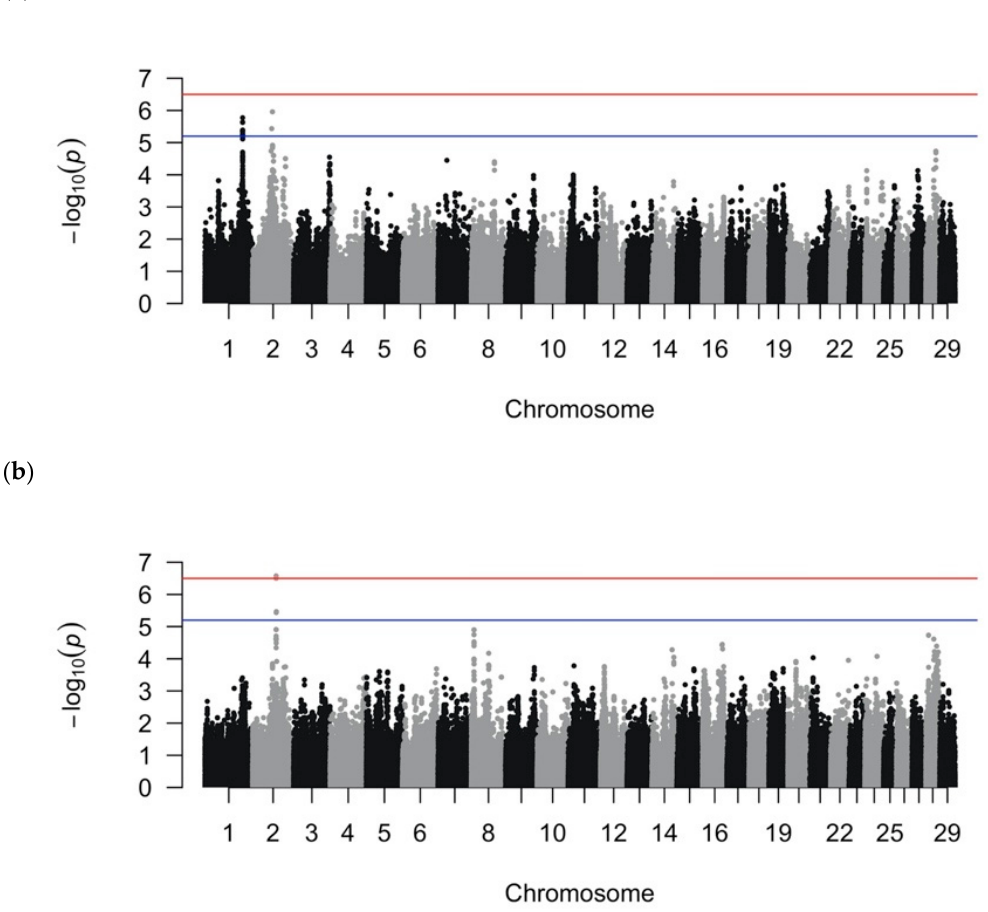
Figure 1. Manhattan plots from the linear mixed model genome-wide association analyses using ( a ) binary phenotypes designating the presence of digital dermatitis (DD) lesions or the absence of any lameness issues and ( b ) quantitative phenotypes calculated by dividing the number of DD episodes by the total number of hoof trimming records. The red line indicates the threshold for genome-wide significance (Bonferroni-corrected using the number of independent SNPs at p < 0.05), and the blue line indicates the threshold for suggestive significance (Bonferroni-corrected using the number of independent SNPs at p < 1).